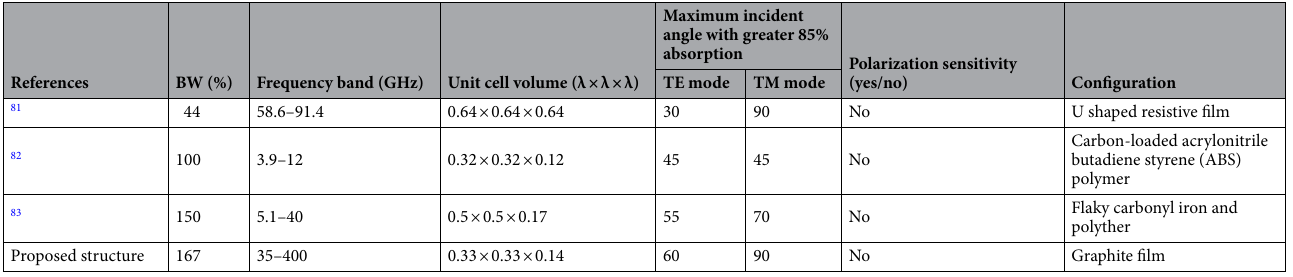
Table 1. Comparison of proposed absorber with previous